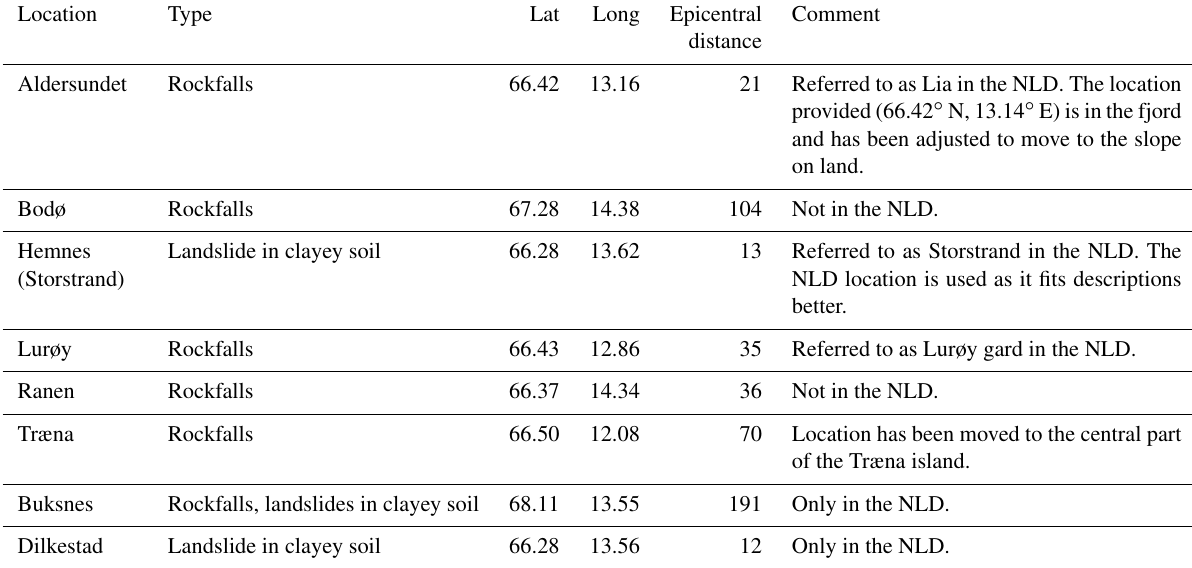
Table 2. Landslides reported in connection with the 1819 Lurøy earthquake. Locations are from Mäntyniemi et al. (2020) if not stated otherwise. Epicentral distance is relative to the BOXER location (66.39 ◦ N, 13.63 ◦ E). NLD: Norwegian landslide database. Location Type